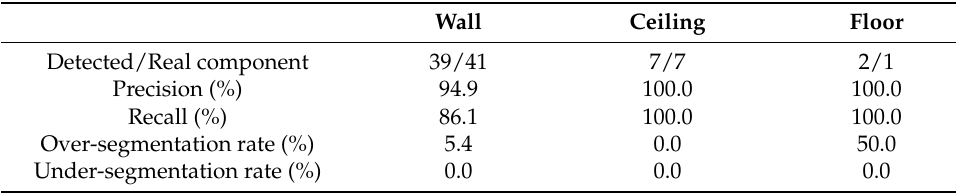
Table 3. Experiment results of Dataset #1.